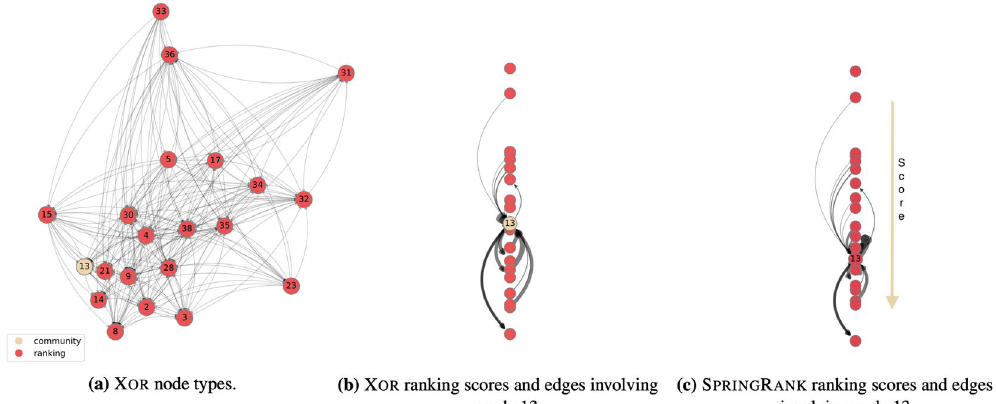
Figure 4. Application on network of parakeets, group 1: visualization of ( a ) the node types Q ; ( b ) ranking scores, as inferred by the Xor model; ( b ) ranking scores inferred by the SpringRank model. In ( b ) and ( c ) we highlight the interactions involving node 13, the only one that Xor infers as interacting via communities, i.e. σ 13 = 0 . The node positions are ( a ) determined with force atlas and (are also point-estimates), ( c ) based on the inferred score s by Xor and SpringRank respectively. In ( b ), ( c ), ranking scores are decreasing from top to bottom, as pointed out by the arrow on the right. Both Xor and MultiTensor detect no meaningful community structure, since they select K = 1 from five-fold cross validation and grid search.